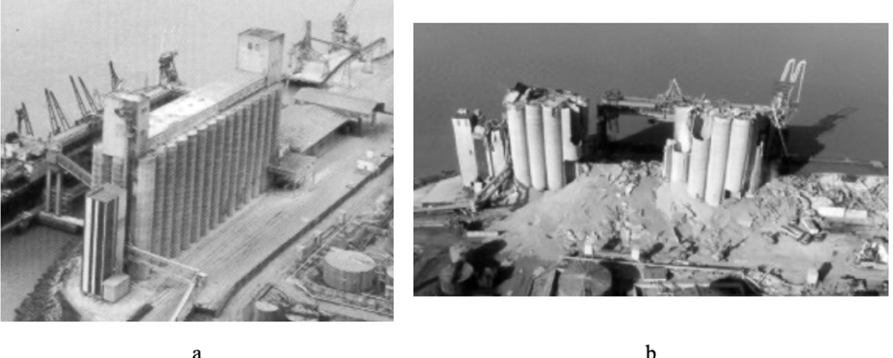
Figure 10. Explosion of RC silo Battery ( a ) before explosion, ( b ) after explosion, Blaye, France, 1998. Source: [138].